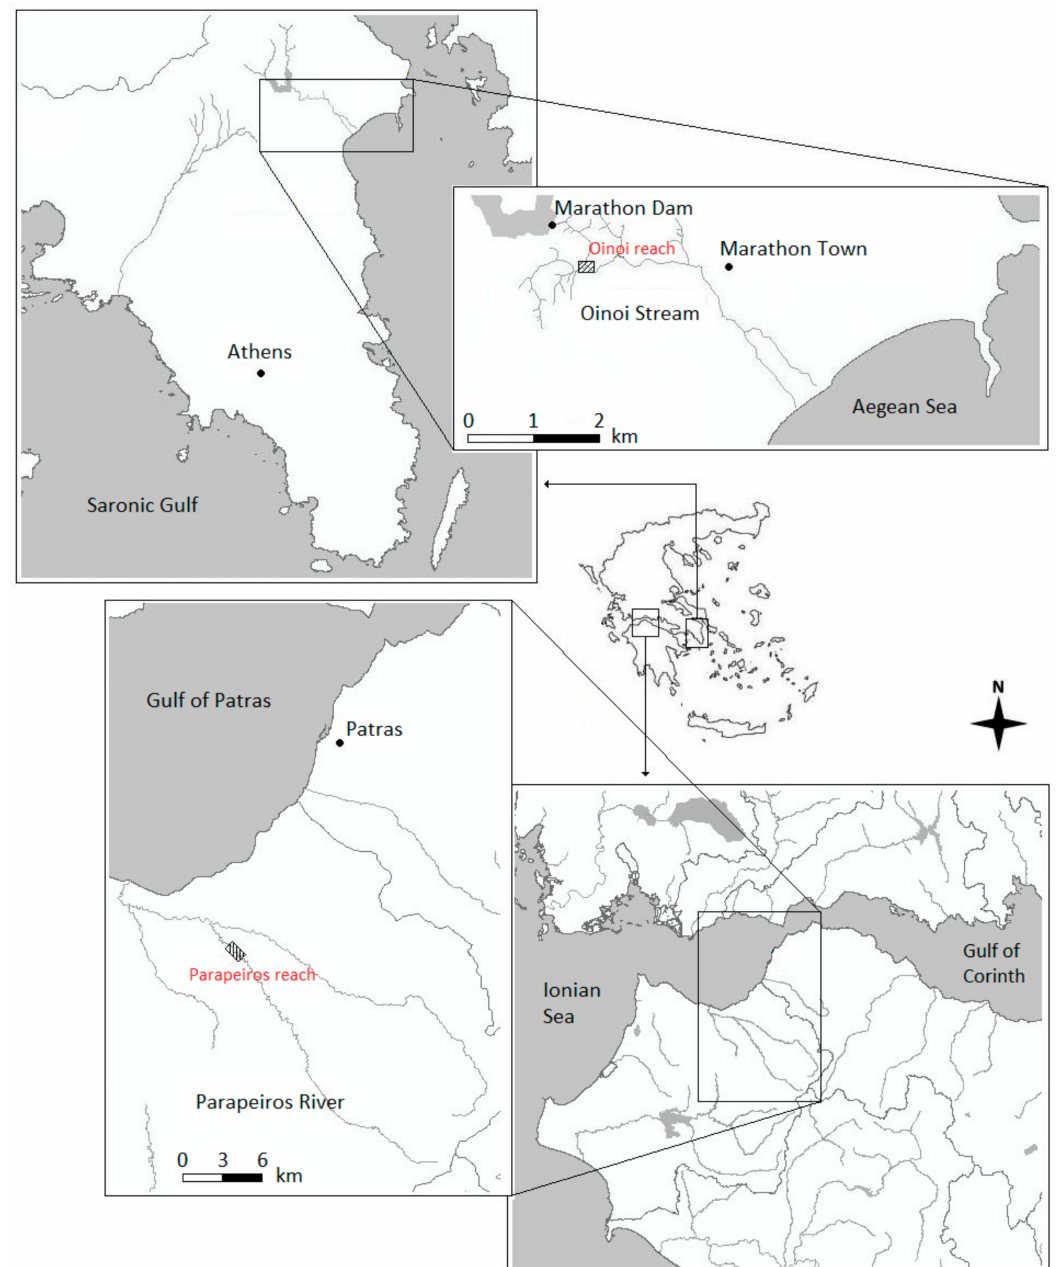
Figure 2. The Parapeiros River and Oinoi Stream where the relevant reaches were hydrodynamically